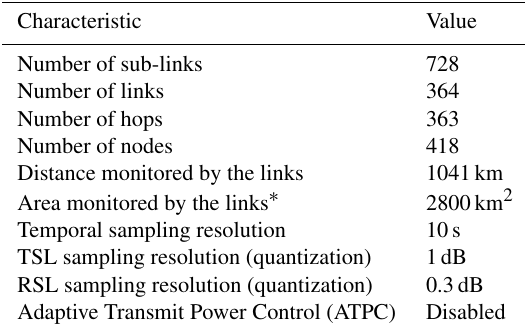
Table 1. General characteristics of the microwave link network. Characteristic Value Number of sub-links 728 Number of links